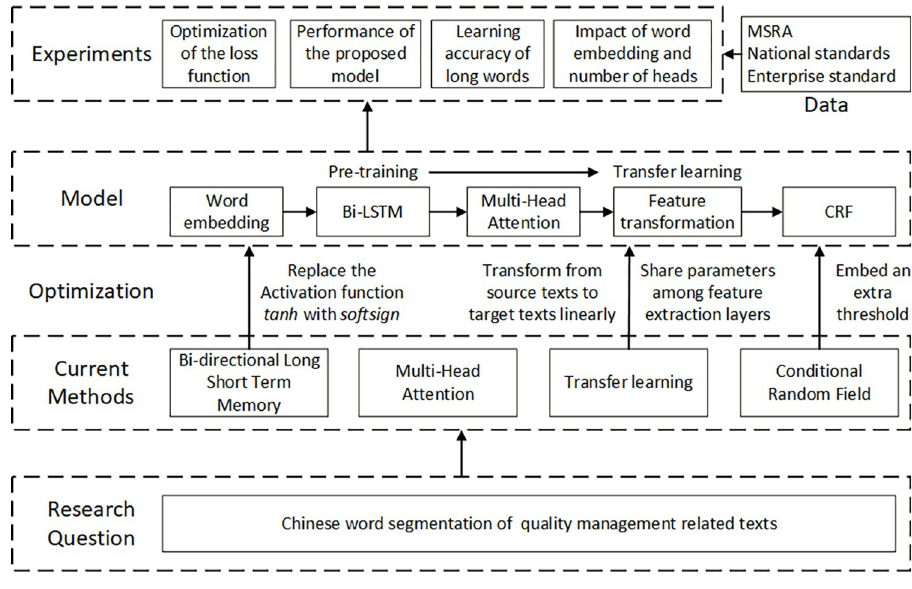
Fig 1. Methodological framework. A hybrid method and related CWS model of mTL-Bi-LSTM-MA-CRF are put forward for QM-related texts and validated with four sets of experiments.